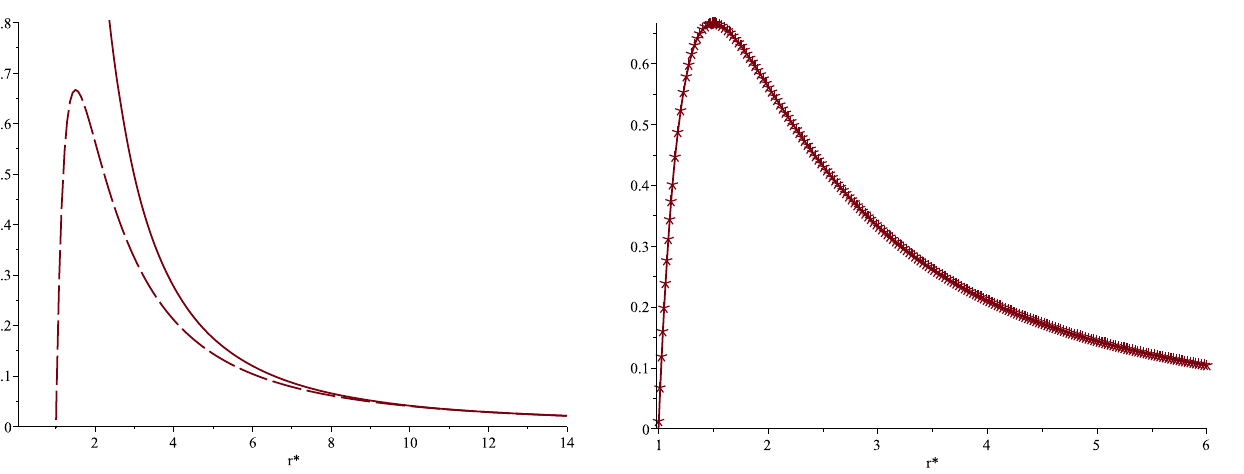
Fig. 7 Plot of the effective potentials (28) (asterisk symbol) (Schwarzschild case) and (30) (solid line) in the massless case when L = 3, H = 0 . 1 and ξ = 1 . 0. Both potentials share the same pho- ton sphere at r ∗ γ = 3 / 2. Both black hole models have the same event horizon at r ∗ s = 1 while for ξ = 1 . 2865 an extreme black hole with radius r e = 2 . 33 × 10 − 7 pc < R BH = 3 . 92 × 10 − 7 pc. Finally,